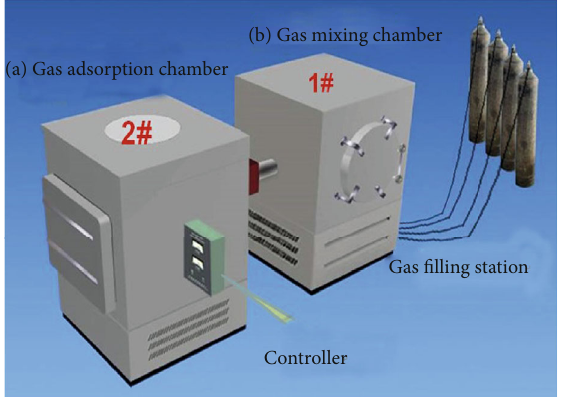
Figure 8: Soft rock gaseous water and water intelligent test